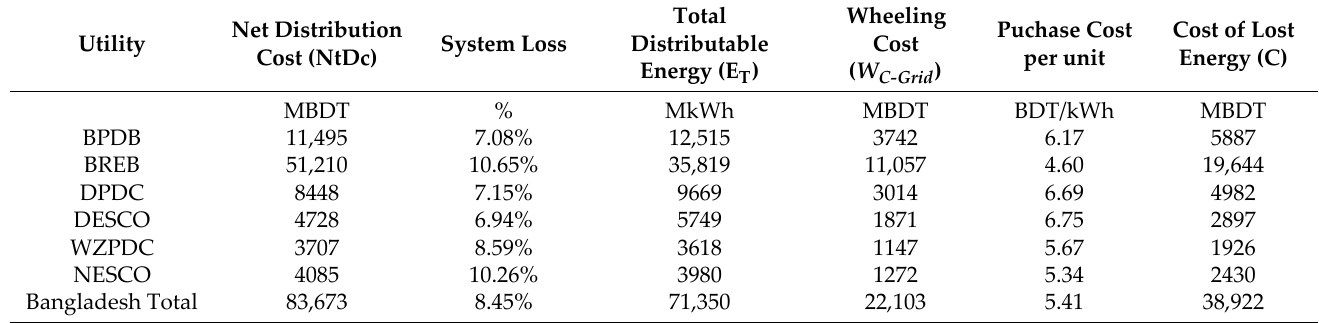
Table 3. Parameters for utility‑wise distribution and transmission wheeling cost estimation. Data